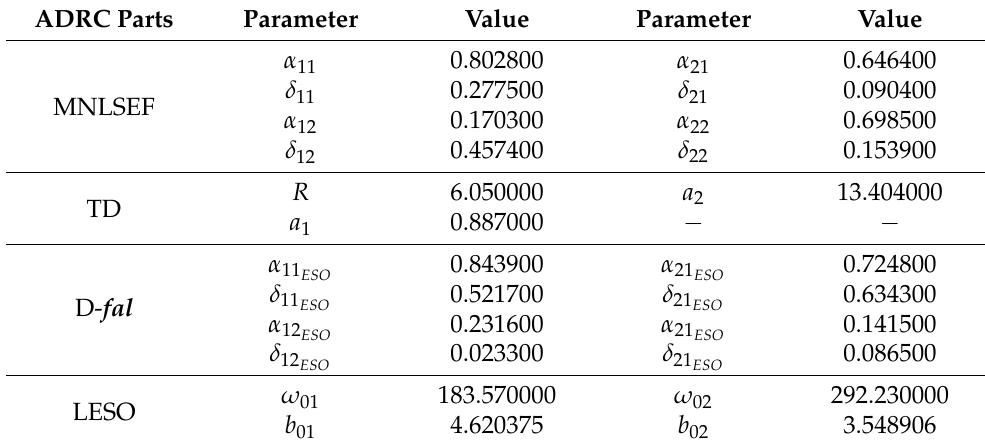
Table 13. D f al -ADRC-TD parameters (2nd MADRC